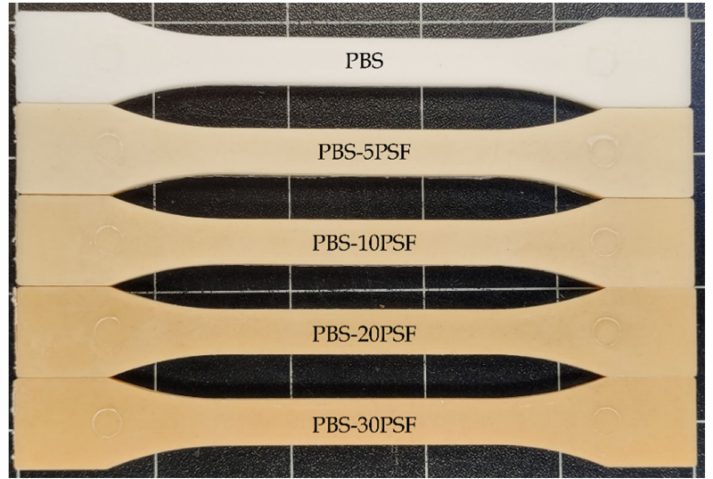
Figure 2. Visual appearance of the injection-molded pieces of poly(butylene succinate) (PBS)/pistachio shell flour (PSF) compatibilized with poly(butylene succinate) grafted with maleic anhydride (PBS- g